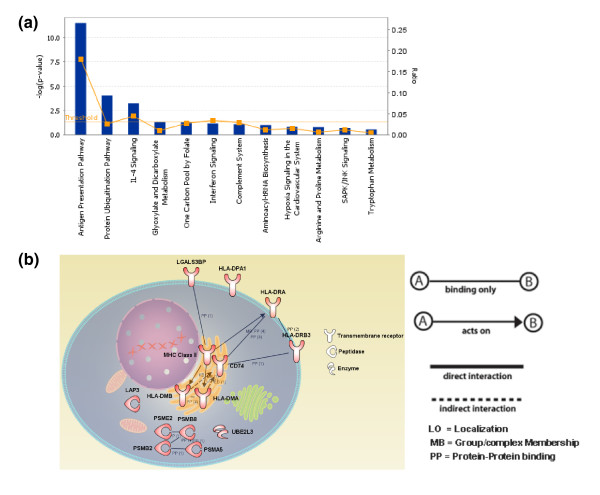
Canonical pathway and gene network analysis of the 37 classifiers. (a) The 37 classifiers were analyzed using ingenuity pathway analysis and the classifiers were grouped to 12 canonical biological process pathways. The antigen presentation pathway (7 molecules) and protein ubiquitination pathway (5 molecules) were found to be the dominant canonical pathways represented by these set of classifiers. The orange squares indicate the ratio of the number of genes from the dataset that map to the canonical pathway, whilst the solid blue bars correspond to the P-value representing the probability that the association between the genes in the classifier set and the identified pathway occurs by chance alone (calculated by Fischer's exact test, and given as a log P-value). A representative gene network of the dominant canonical pathways was then generated (b). Transcripts that are overexpressed in patients with melioidosis are indicated by a red color. The function of the gene product is represented by a symbol. Connections between the gene products and the nature of these interactions are shown.